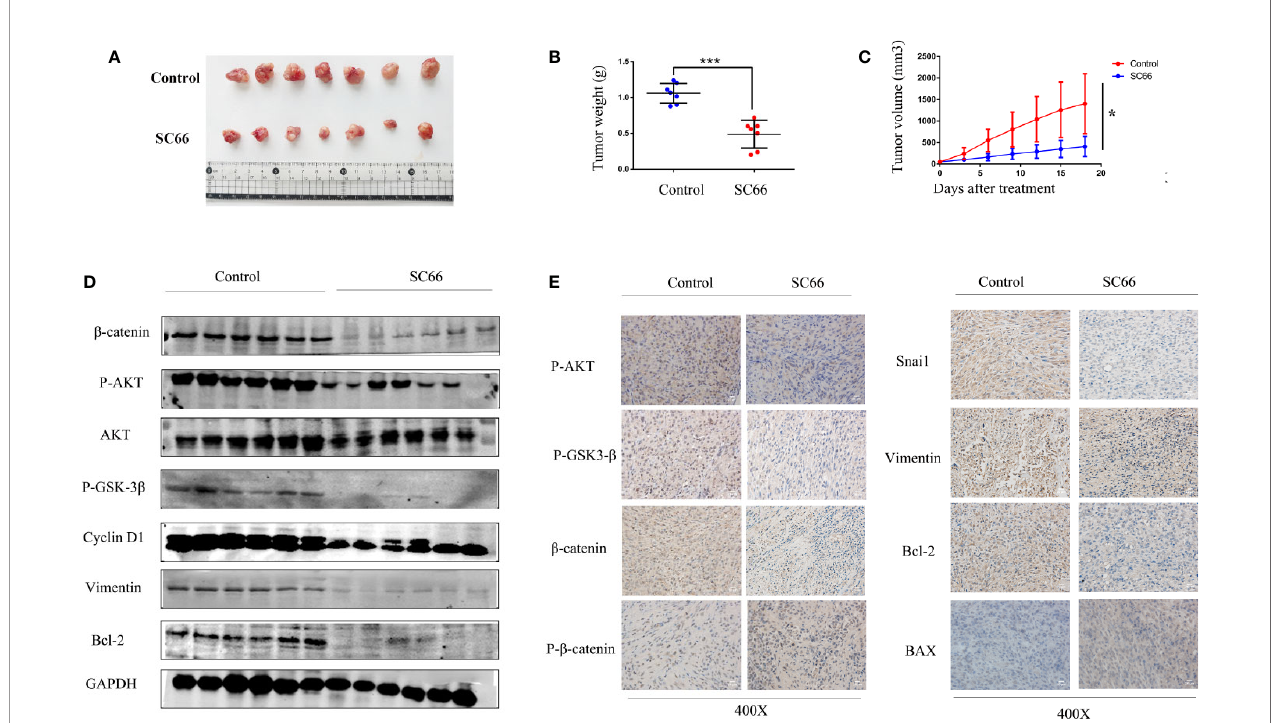
FIGURE 7 | SC66 suppressed tumor growth in nude mouse models. (A) Image of the xenograft tumors formed in nude mouse models. (B, C) Tumor weight and tumor volume were calculated. (D) Western blot assay of main protein expression of control group and SC66-treated group. (E) Representative images of IHC staining of P-AKT,P-GSK-3 b , b -catenin, P- b -catenin, Snai1, MMP2, Bax, Bcl-2, and Cleaved-caspase3. *P < 0.05, ***P <